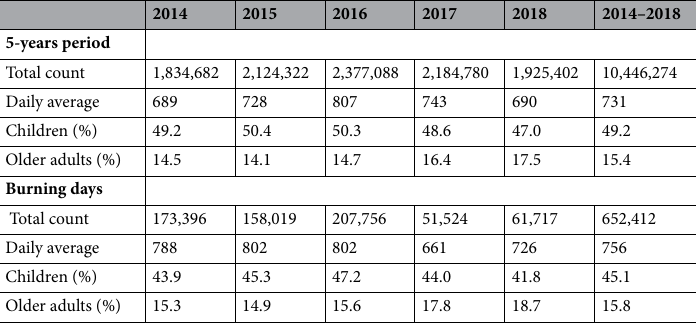
Table 1. Summary of hospital visits for respiratory diseases in UNT during 2014–2018.